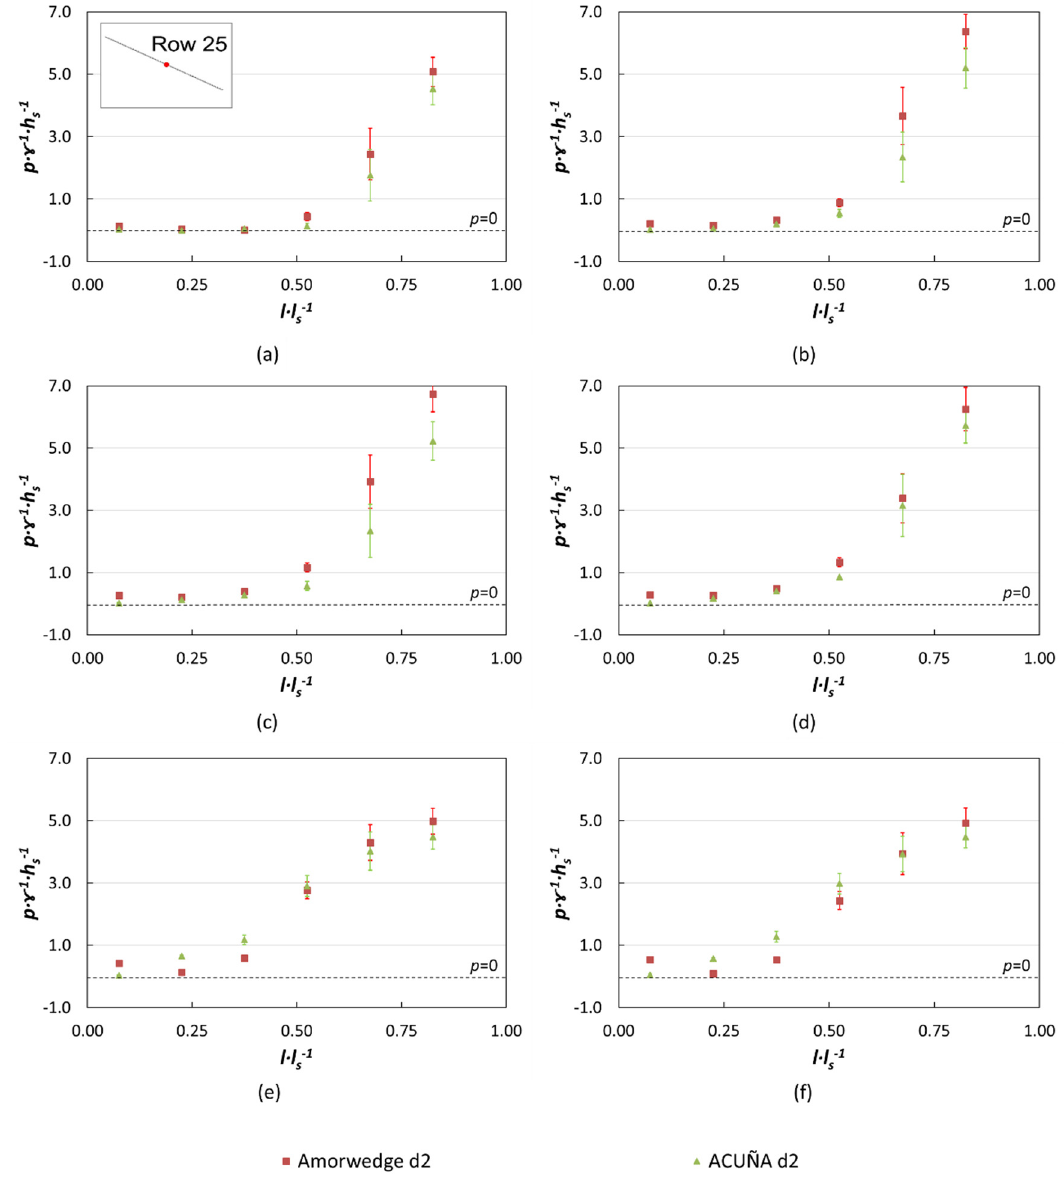
Figure 14. Average and standard deviation of the hydrodynamic pressures registered on the tread of Armorwedge TM ( w 1) and ACUÑA ( w 2) block in row 25 of the chute for different unit discharges simulating blocks laid over an impervious soil with an intermediate and permeable bedding granular layer ( d 2): ( a ) 0.04 m 2 s − 1 , ( b ) 0.08 m 2 s − 1 , ( c ) 0.10 m 2 s − 1 , ( d ) 0.12 m 2 s − 1 , ( e ) 0.16 m 2 s − 1 and ( f ) 0.20 m 2 s − 1 .